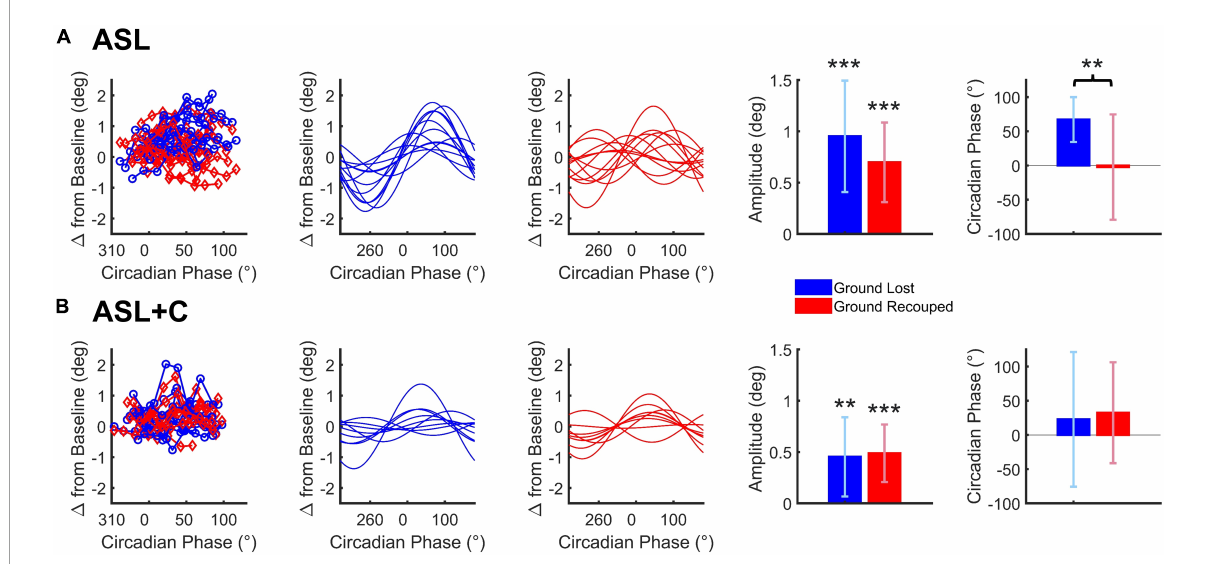
FIGURE6 Cosine analysis of ground lost vs. ground recouped (depicted in blue and red, respectively) for ASL (A) and ASL+C (B) . Raw data for ground lost and ground recouped data are shown in the leftmost panels with cosine fits of the ground lost and ground recouped in separate adjacent panels. Bar charts represent the across-subject average ( ± SD) of the best-fitting amplitude and phase parameters. * p < 0.05, ** p < 0.01, and *** p < 0.001.